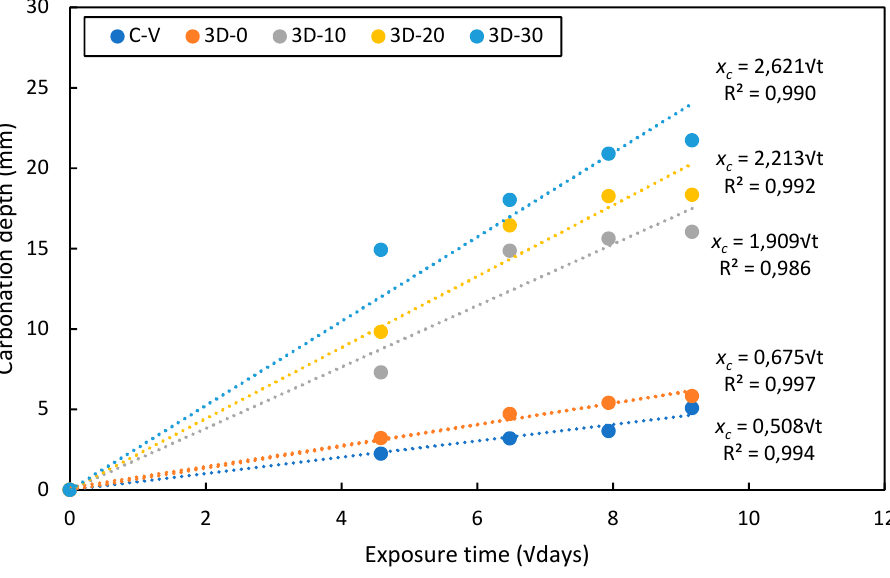
Figure 15. Carbonation depth progression over the 12-week ACC testing over the square root of time ( √ days).